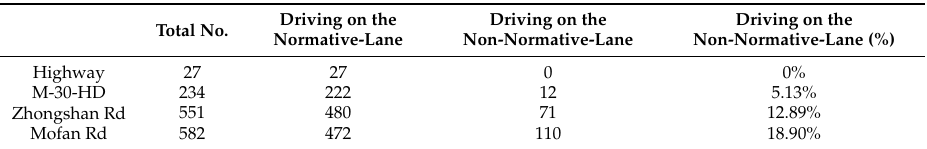
Table 11. Non-normative driving in each